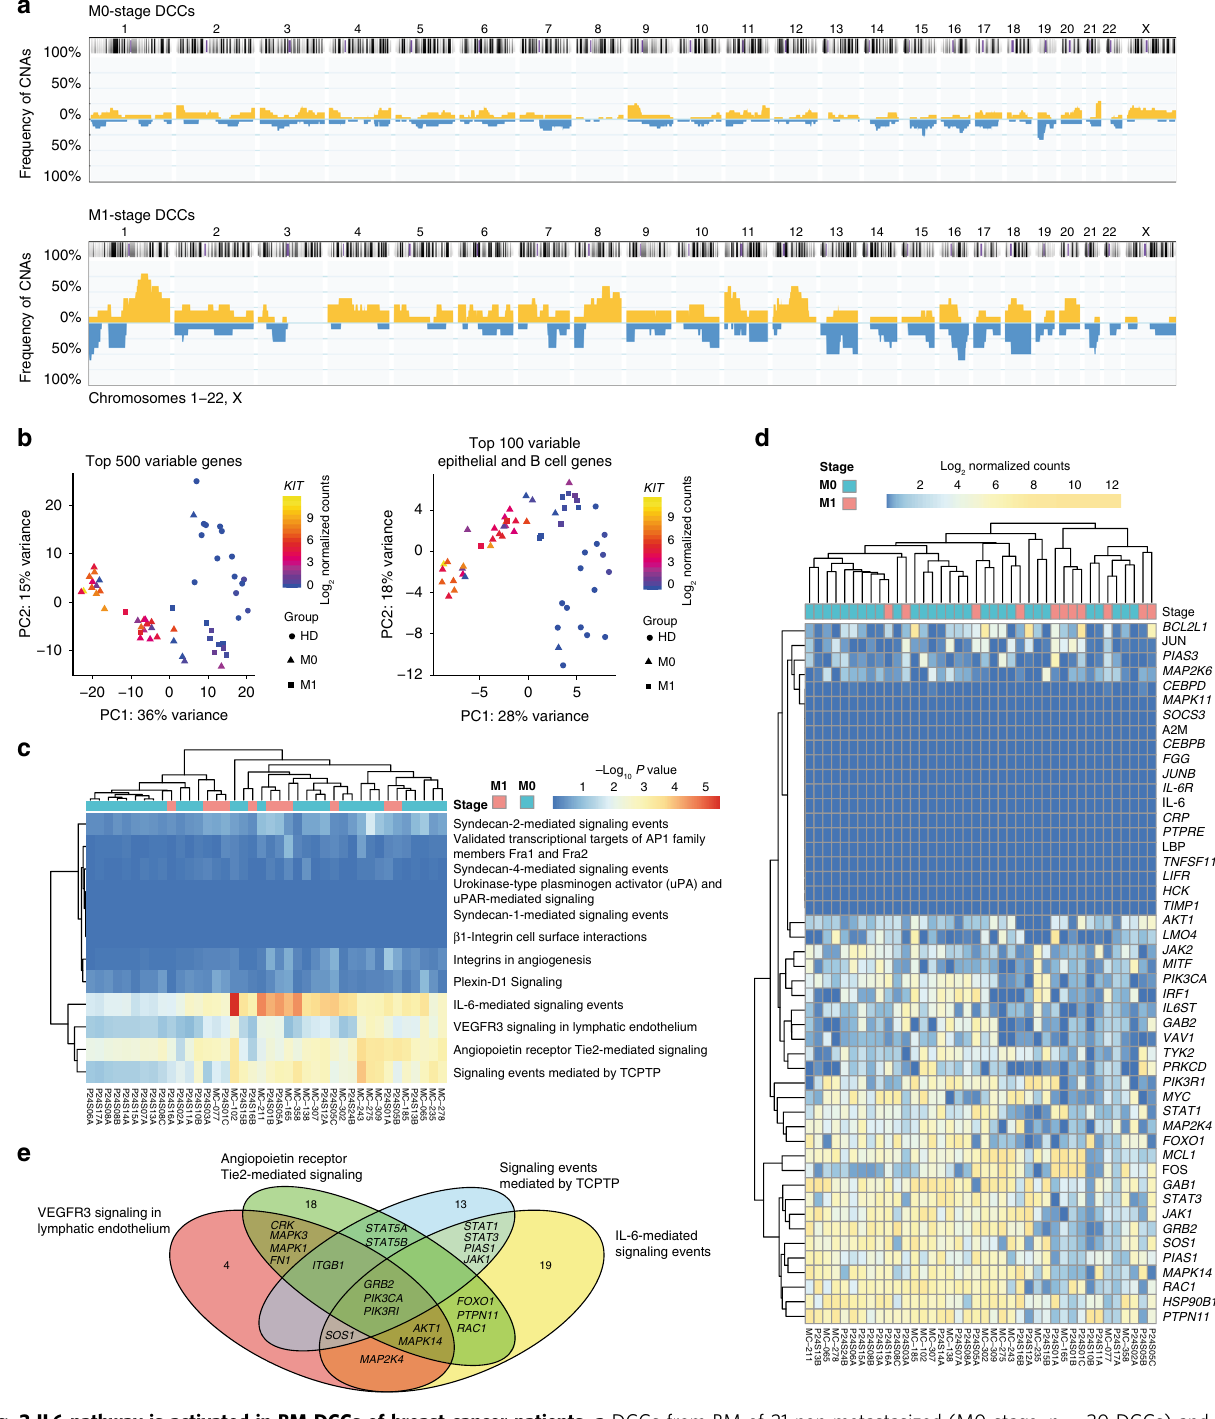
Fig. 3 IL6 pathway is activated in BM-DCCs of breast cancer patients. a DCCs from BM of 21 non-metastasized (M0-stage, n = 30 DCCs) and fi ve metastasized (M1-stage; n = 11 DCCs) breast cancer patients were analyzed for CNAs. The cumulative frequency of genomic aberrations is given in yellow and blue indicating genomic gains and losses, respectively. M0-stage ( b , c n = 30; d , e n = 29 and M1-stage ( n = 11) DCCs and EpCAM + BM cells of seven healthy donors, i.e. patients without malignant disease (HD; n = 15 cells) were analyzed by single cell RNA sequencing. b Principal component analysis of the top 500 most variable genes or top 100 most variable epithelial and B cell genes. c DCCs were tested for enrichment in pathways identi fi ed to be enriched in LRCs over QSCs/nLRCs (see Fig. 2d). d The heatmap displays log2 normalized read counts of mRNA expression of IL6 signaling pathway genes as listed in the NCI-Nature PID expanded by the LIFR gene. e Venn diagram for the gene-members of the four pathways ( d ) that are expressed in at least half of bone marrow DCCs (except for the BMX (5/40) and CEBPD (19/40) genes, Supplementary Fig. 1d). Pathway-private genes are annotated by their number, shared genes are named explicitly (see also Supplementary Table 5). See Supplementary Table 1 for patient/sample-ID